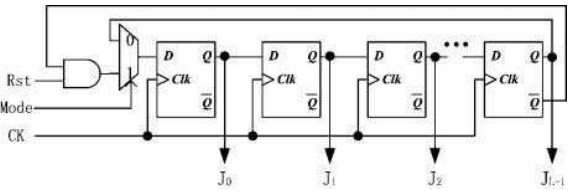
Figure 2. L-bit reconfigurable Johnson counter